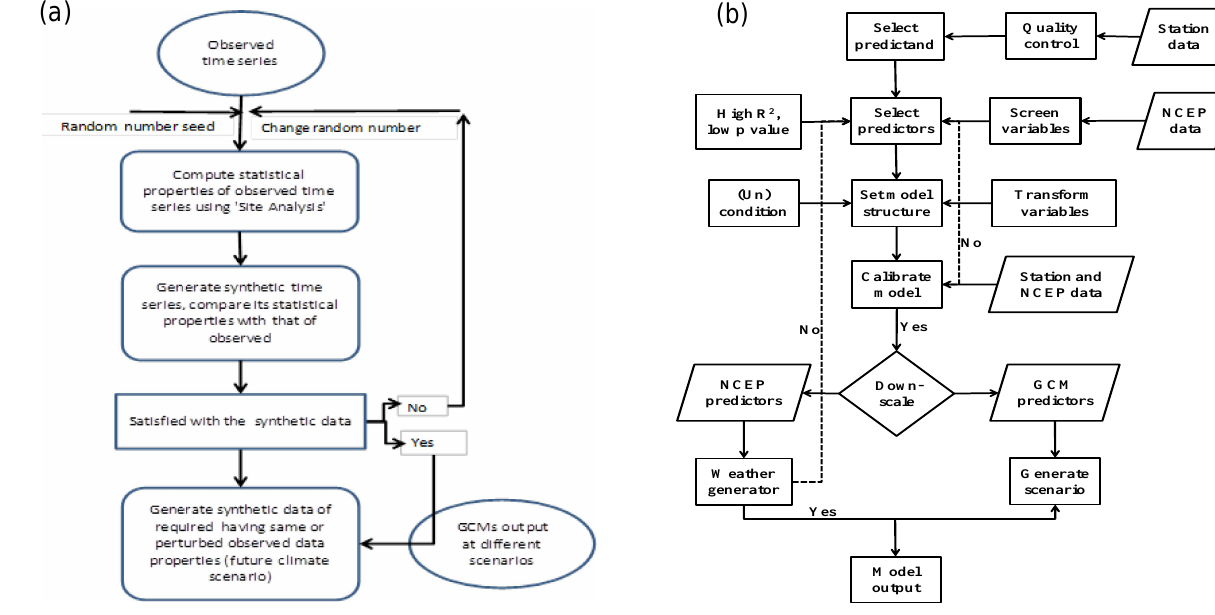
Figure 2. Schematic diagram of (a) LARS WG analysis and (b) SDSM analysis. Source: Wilby et al.